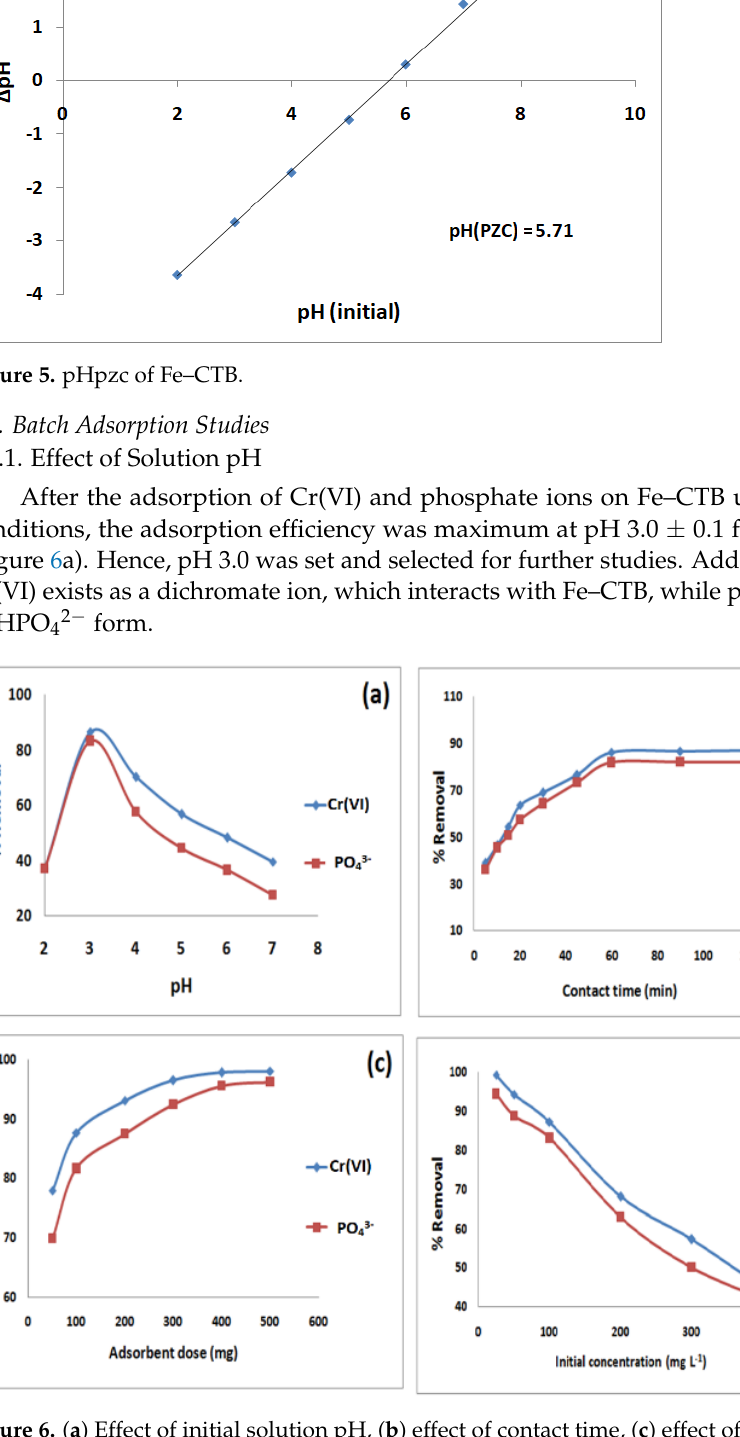
Figure 6. ( a ) Effect of initial solution pH, ( b ) effect of contact time, ( c ) effect of adsorbent dose, and ( d ) effect of initial concentration on the adsorption efficiency of Fe–CTB towards Cr(VI) and PO 4 3 −.